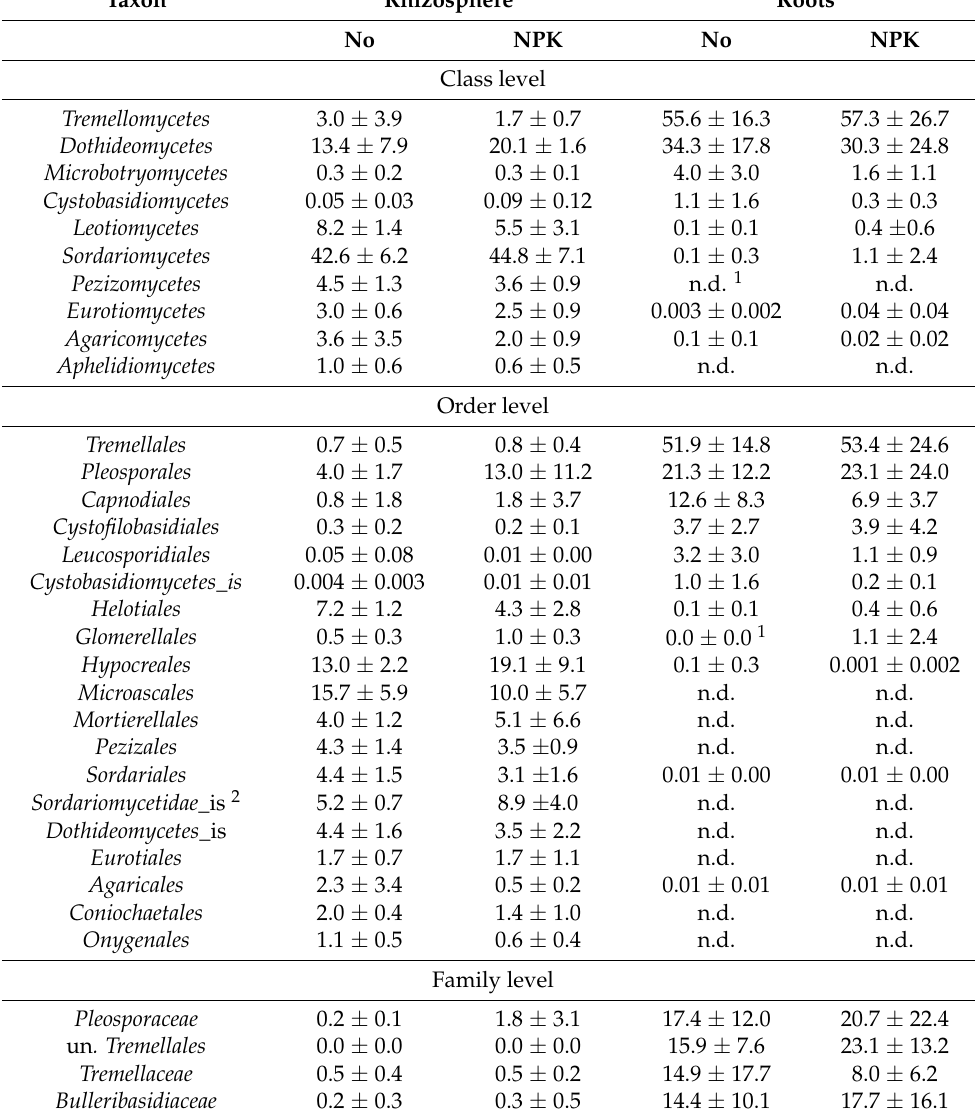
Table 4. The relative abundance (%, mean ± standard deviation) of the dominant fungal taxa in the rhizosphere and roots of tomato plants, grown under different fertilization on Phaeozem in the open field in the south of West Siberia (a taxon was considered dominant if its relative abundance was ≥ 1.0%). Taxon